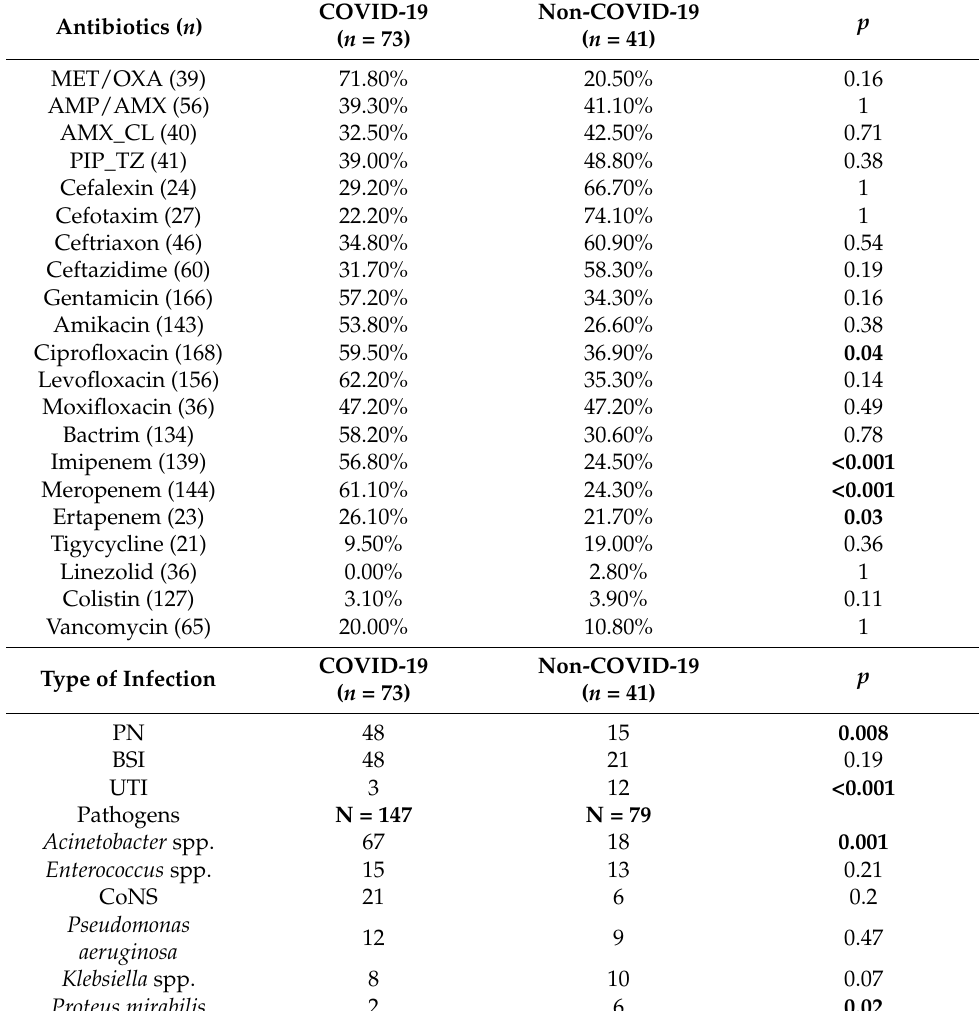
Table 4. Resistance rates, types of infection, and pathogen distribution in COVID-19 vs. non-COVID- 19